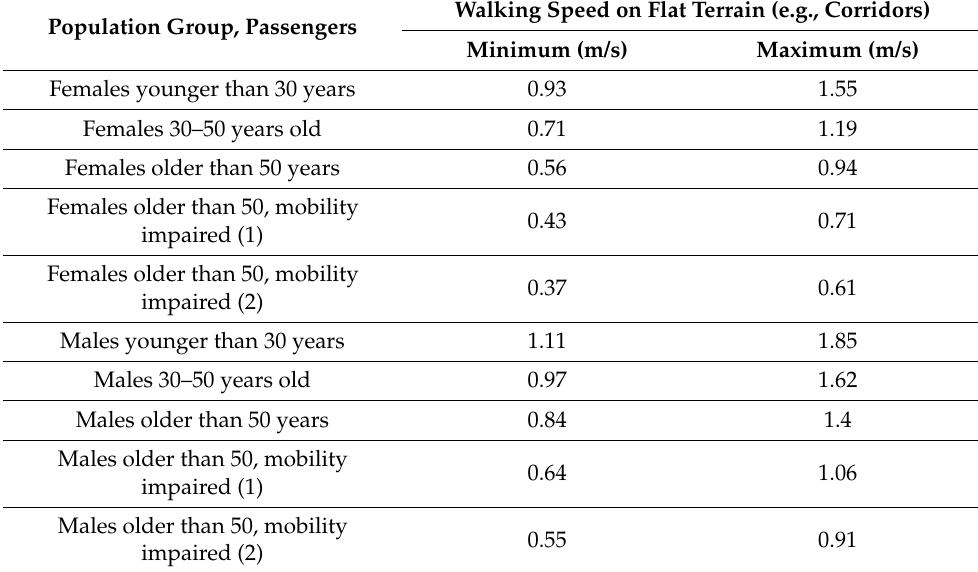
Table 2. Walking speed of demographic groups on a flat terrain